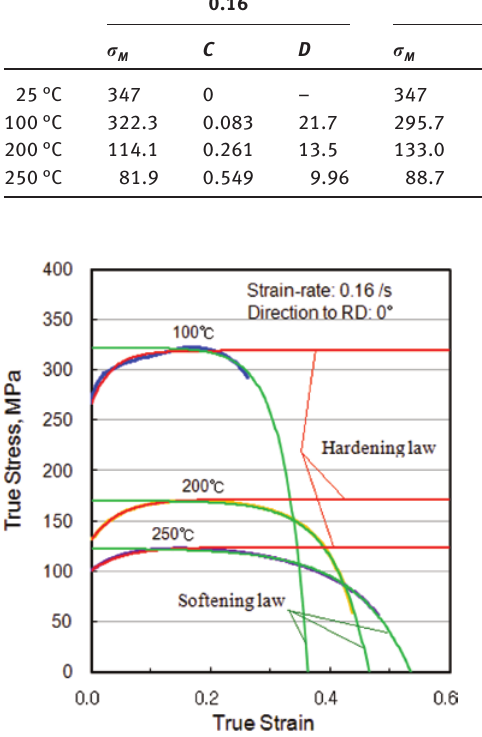
Fig. 2: Voce’s work-hardening and softening laws at elevated